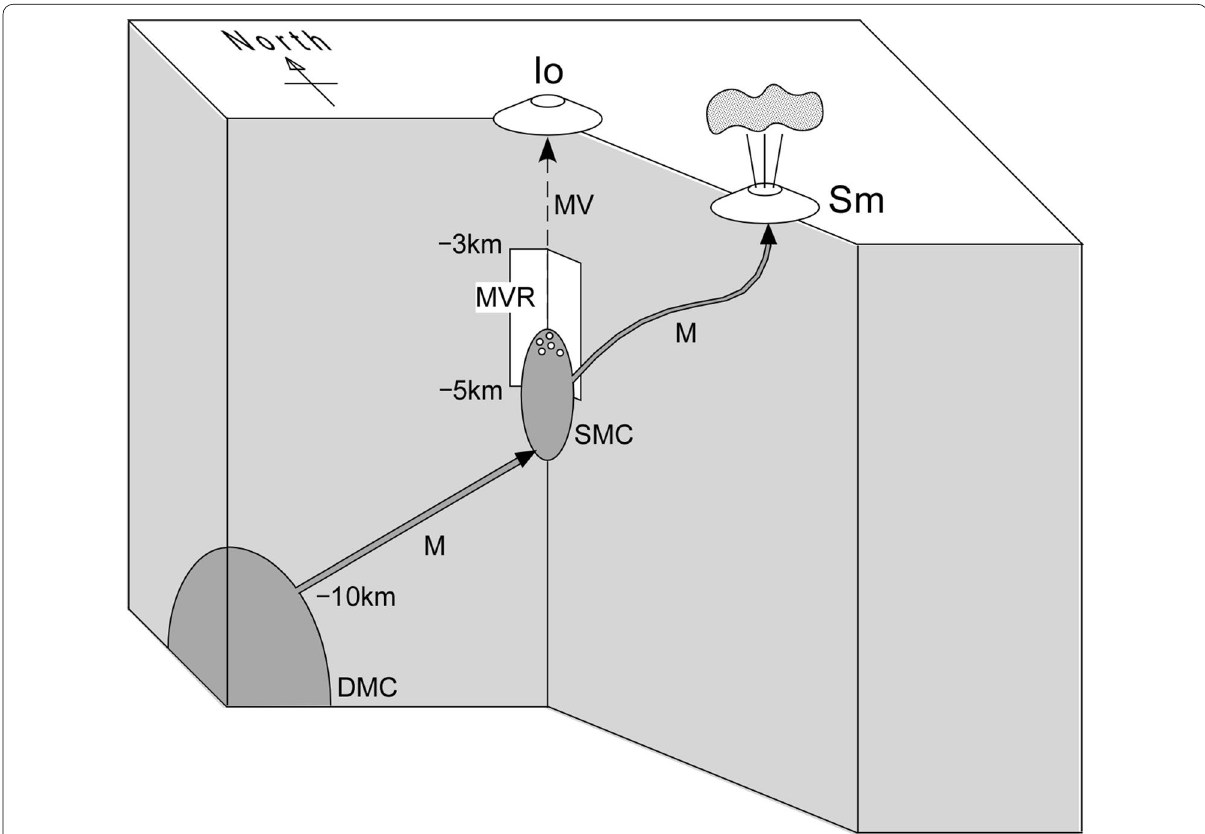
Fig. 2 Schematic illustration of the magma plumbing system revealed by a previous 3D-MT survey (Aizawa et al. 2014). MV and M refers to magmatic vapor and magma, respectively. Io and Sm denote the Ioyama and Shinmoedake volcanoes, respectively. MVR, SMC and DMC are the magmatic vapor reservoir, shallow magma chamber and deep magma chamber,